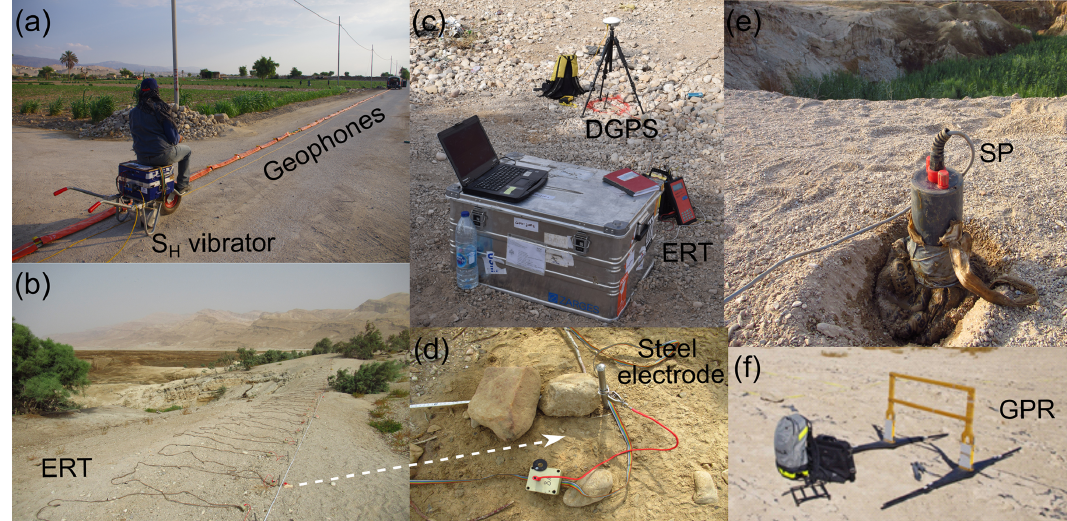
Figure 4. Ground-based images of the ERT, SP and seismics equipment. (a) Seismics line 1 with landstreamer geophone system and ELVIS S H shear wave generator system. (b) ERT line 3 at the head of canyon CM5 with electrode chain ActEle spread. (c) ERT Lippmann 4point light and DGPS Trimble ProXRT-2 equipment. (d) Close-up of stainless-steel electrode, connecting cable and switch box of the multi- electrode ERT system. (e) SP Ag–AgCl electrode in a cotton bag filled with bentonite and watered to improve electric ground coupling. (f) GPR Malå Ramac device with a 50MHz transmitter and receiver